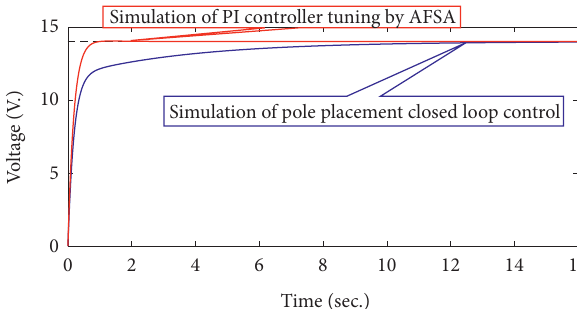
Figure 10: Simulation of closed-loop control using PI controller tuned by AFSA.